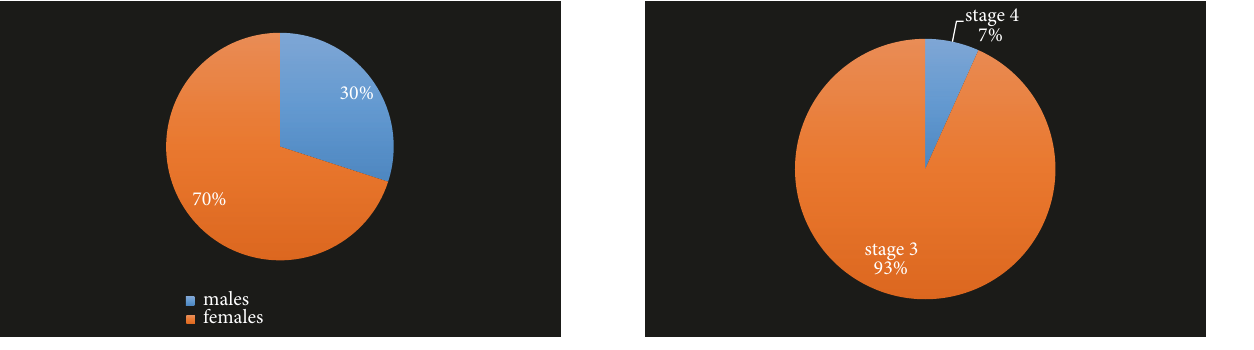
Figure 3: Relative prevalence of moderate-to-severestages of CKD in the